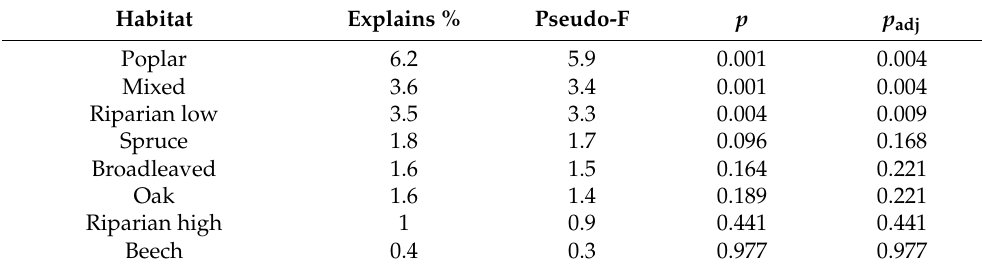
Figure 3. Species-habitat biplot diagram from CCA summarising the effect of forest type (red triangles) on species composition. Empty triangles indicate the centroids for the small mammal species. The codes for species are given by the initial of genus and first three letters of species name. Riparian forests were divided into two distinct types, those of lowlands (riparian low) and those of mountains (riparian high). Table 2. Simple effects of the forest type on species composition of small mammals in the study area. Values of the explained variation (explains %), pseudo-F, unadjusted significance ( p ), and significance adjusted using the false discovery rate procedure ( p adj ) are